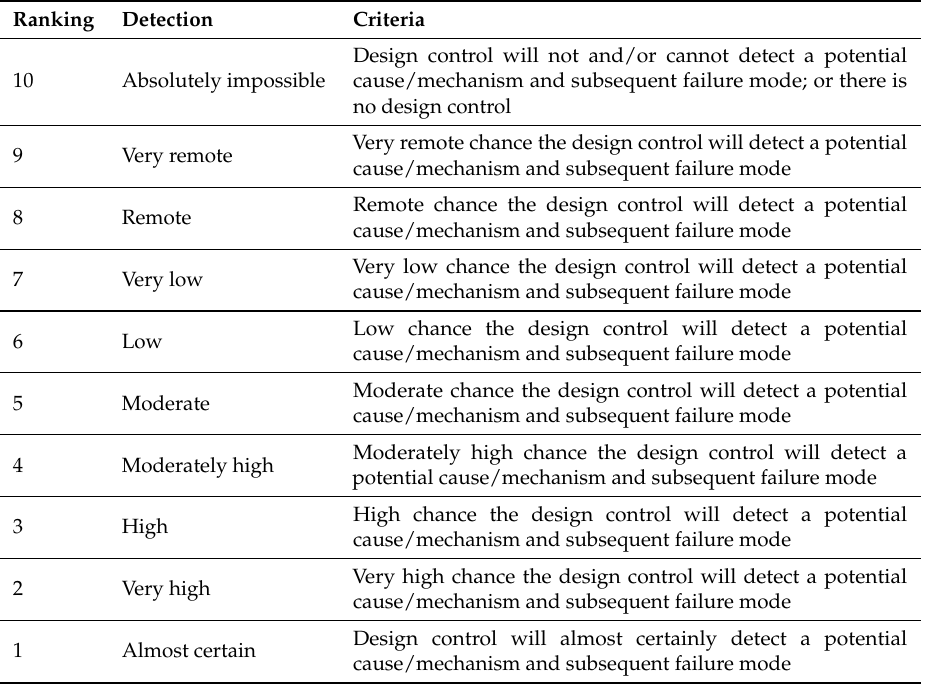
Table 3. Assessment rankings for detection in FMEA